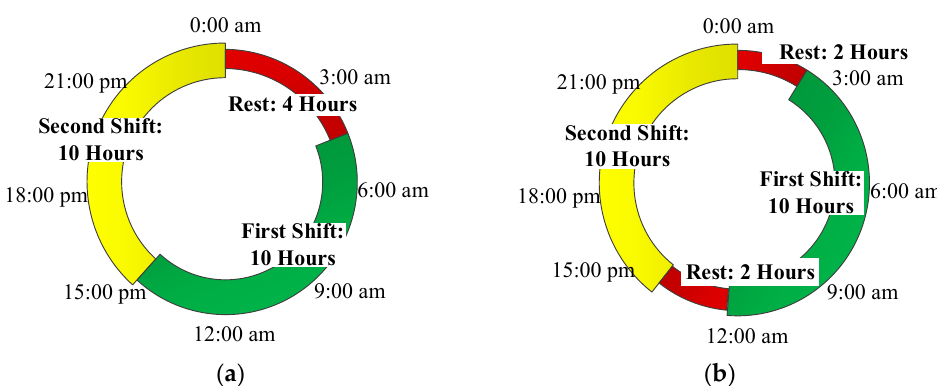
Figure 2. Two-shift operation mode in China: ( a ) the shift operation mode in the first instance; ( b ) the shift operation mode in the second instance.